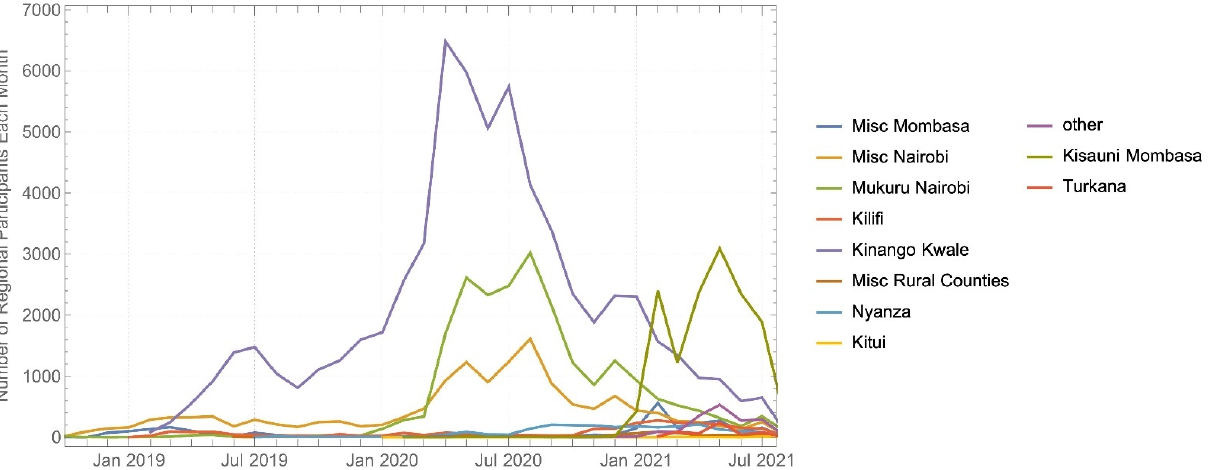
Figure 3. Monthly Number of Active Participants By Region. Counted are only members with at least one transaction in the month. The data includes only transactions between CC members and chamas.